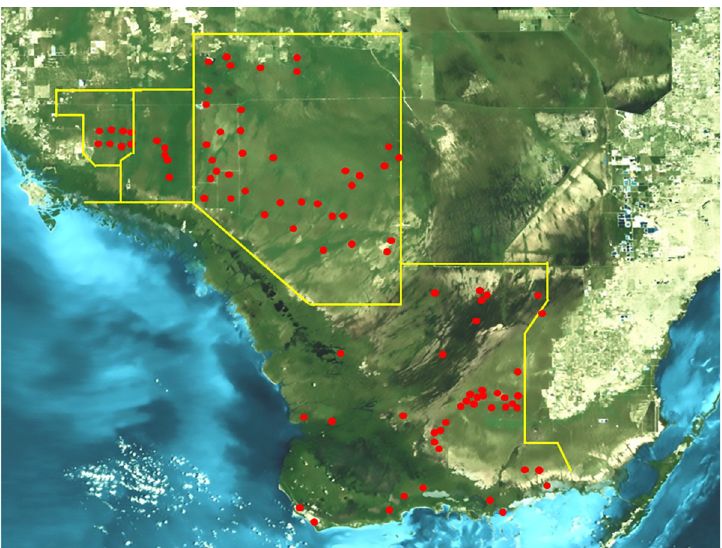
Fig 1. Collection sites. Composite Landsat 7 satellite image showing collection locations in Everglades National Park (EVER), Big Cypress National Preserve (BICY), Fakahatchee State Park Preserve, (FAK) Picayune State Forest Preserve (PY). Image courtesy of USGS/NASA